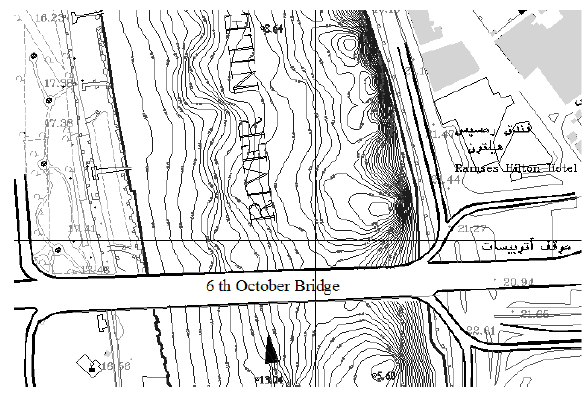
Figure 8. A contour map for River Nile bed at the year